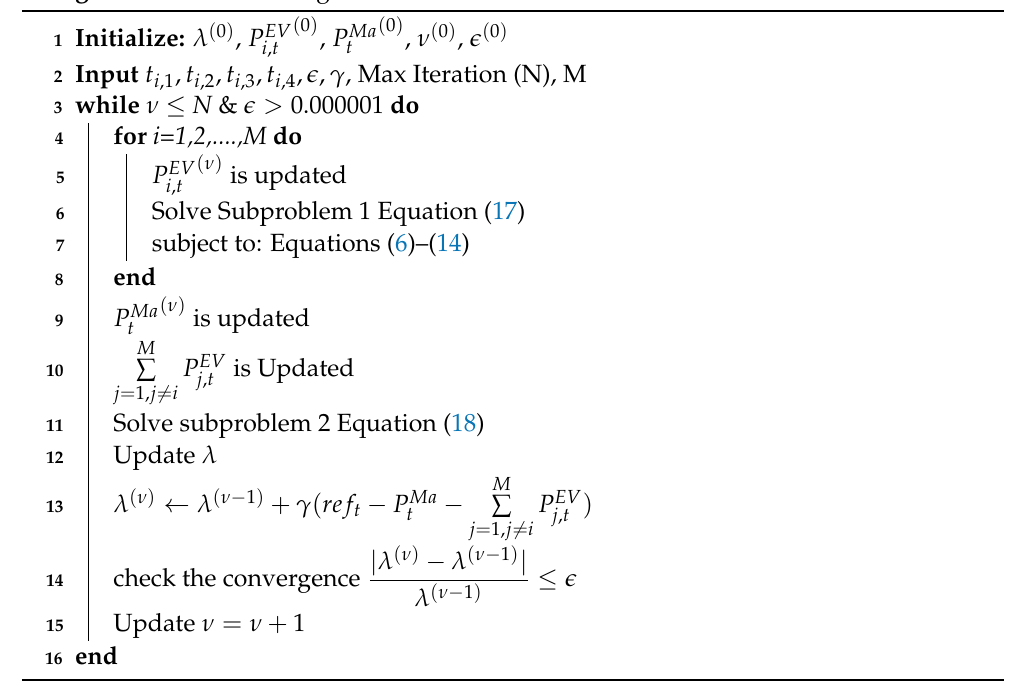
Algorithm 1: ADMM